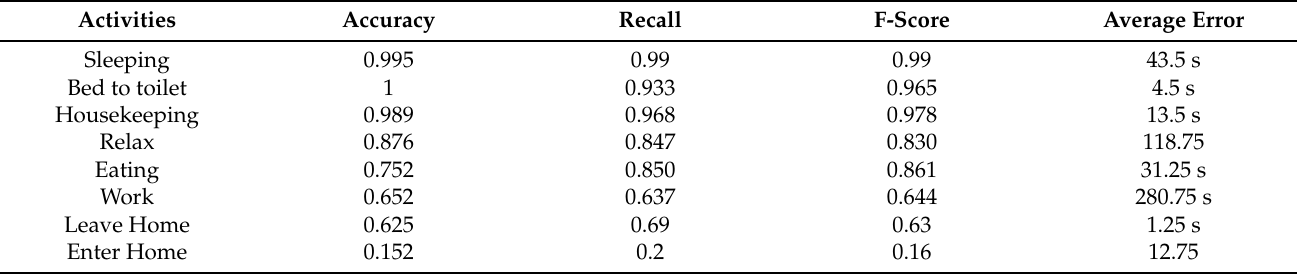
Table 6. Activities recognition performance evaluation on 4 November